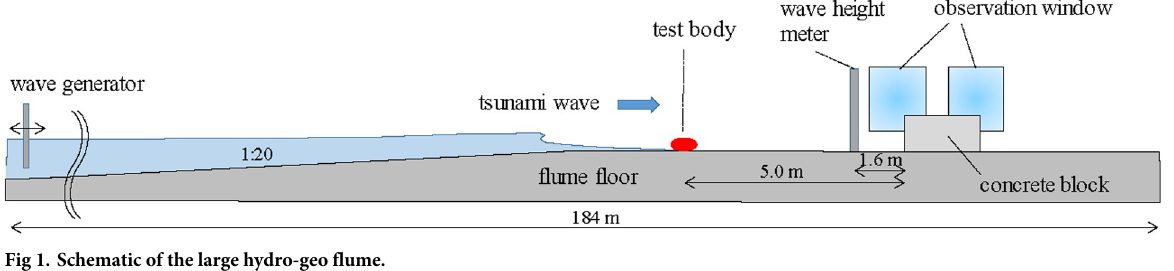
Fig 1. Schematic of the large hydro-geo flume.